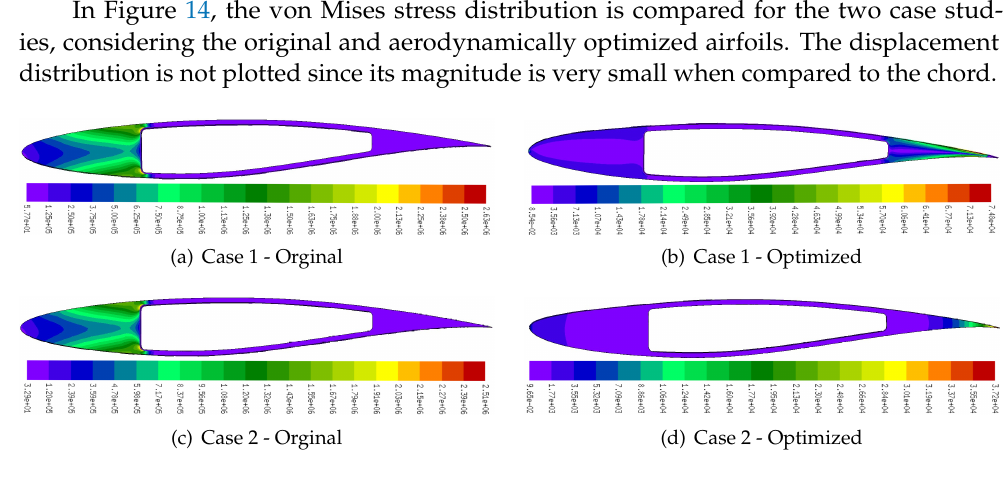
Figure 14. von Mises stress distributions (in MPa) for the two case studies and for the original and aerodynamically optimized